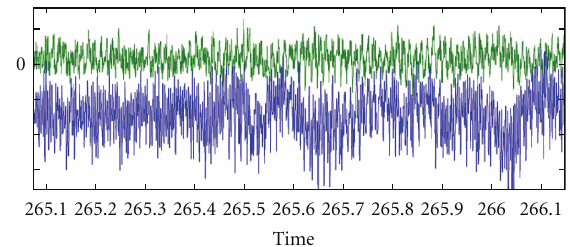
Figure 14: Temporal signals of F y (in blue) and F z (in green) ( N ref , 1.18 Q n